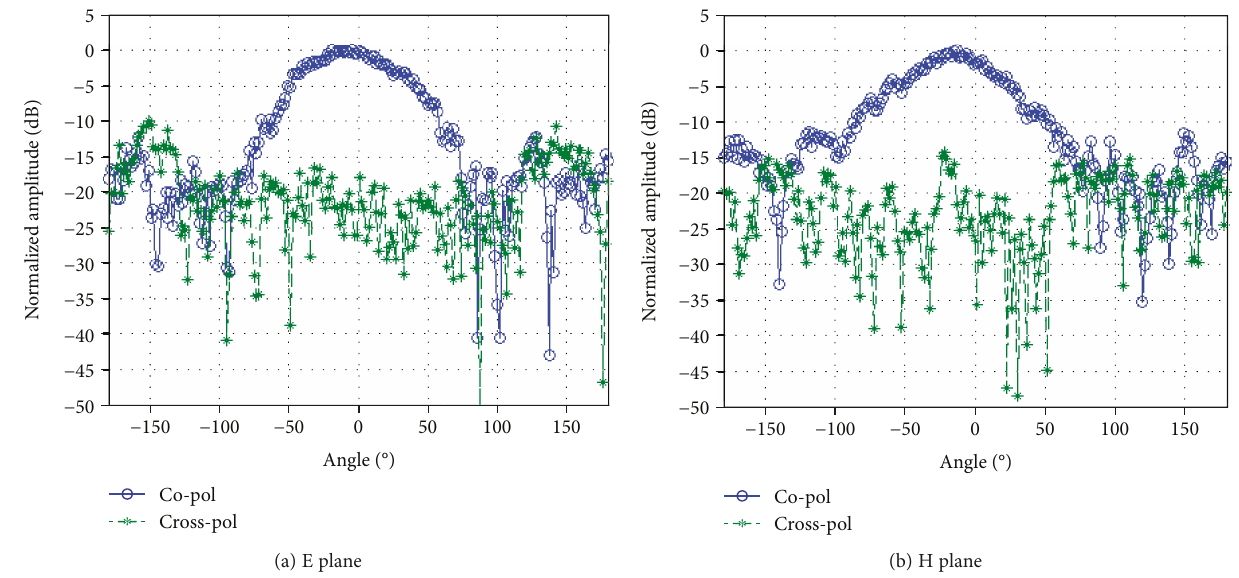
Figure 12: Test patterns of circle aperture